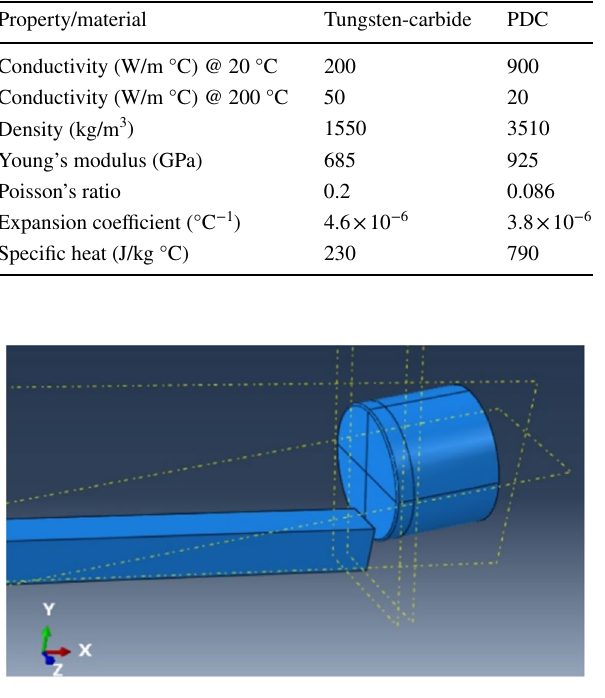
Fig. 1 3D view of interaction of formation and cut